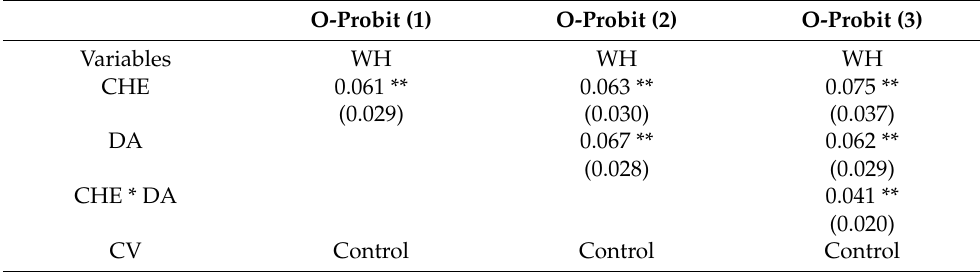
Table 7. The results of the moderation effect test for CHE and WH: